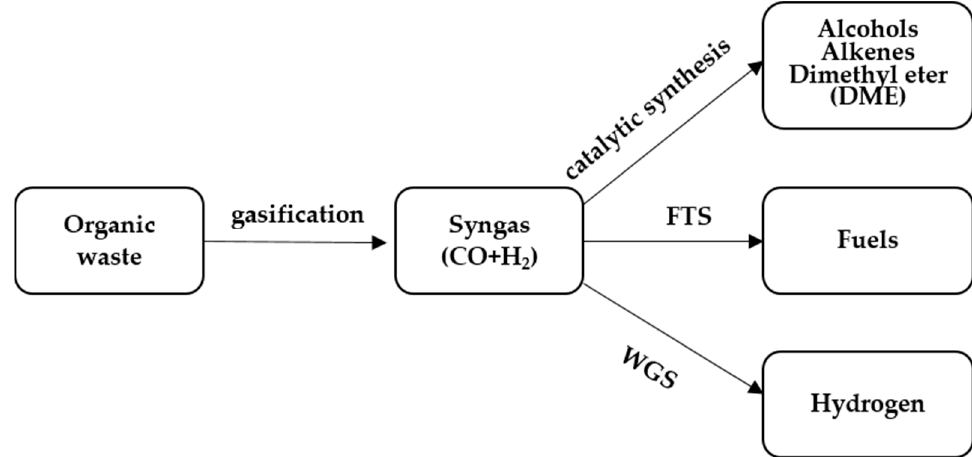
Figure 4. Schematic representation of the gasification processes involved in a thermochemical conversion of organic waste biomass. FTS—Fischer–Tropsch process; WGS—Water Gas Shift.